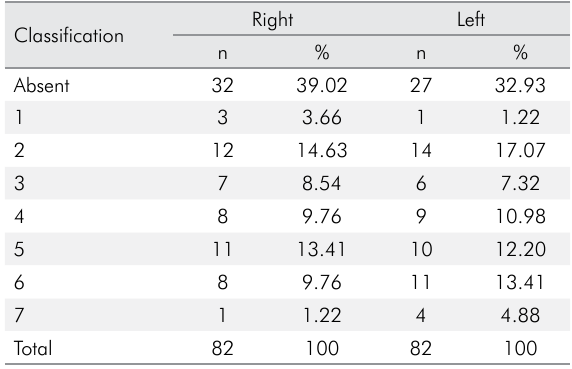
Table 3. Absolute and relative numbers of location classification in accordance with Oliveira-Santos et al.11 for male subjects.